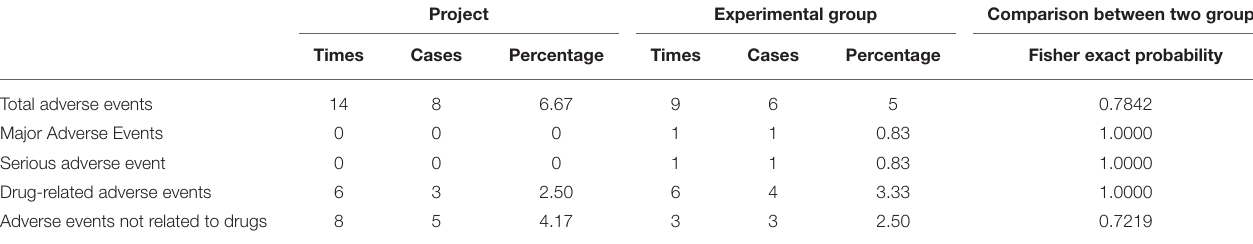
TABLE 12 | Adverse